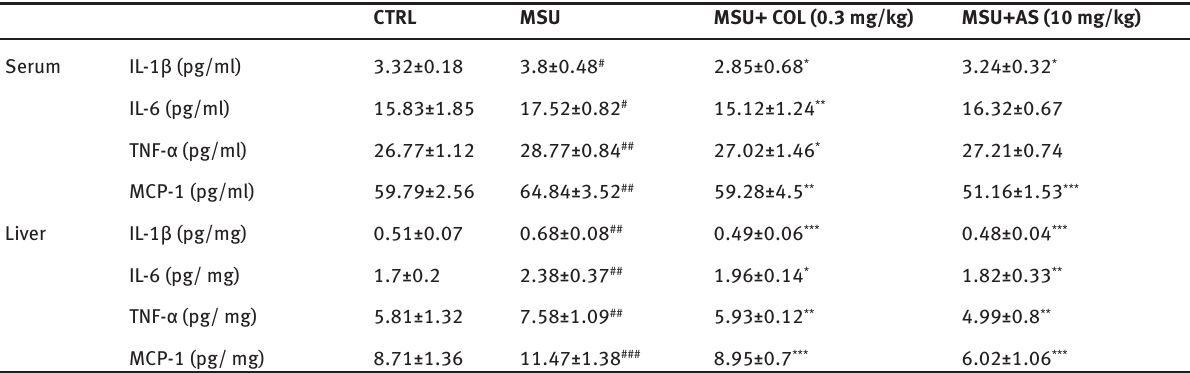
Table 2: The effect of COL and AS on the the inflammation cytokines in rats with acute gouty arthritis. CTRL MSU MSU+ COL (0.3